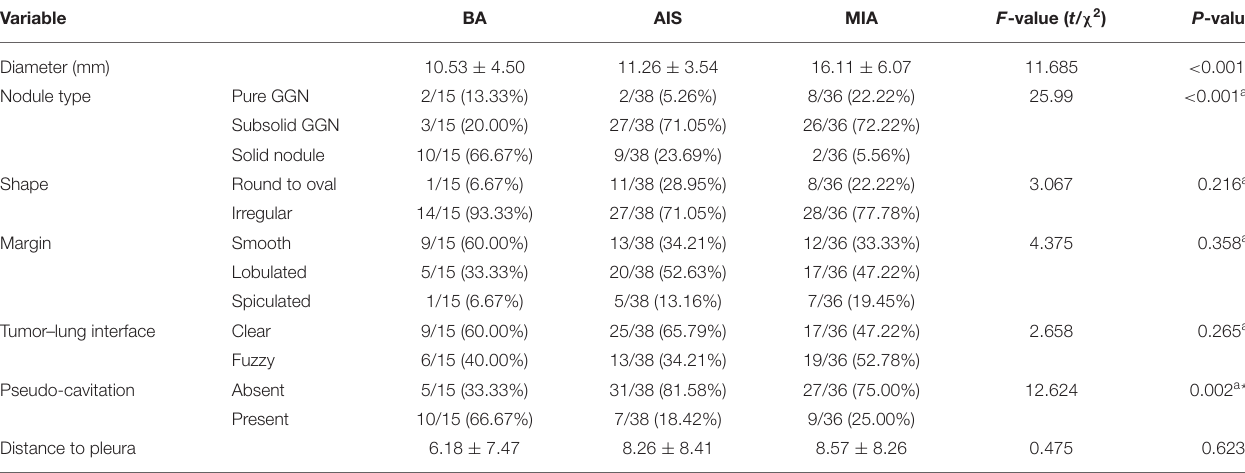
TABLE 2 | Differences in CT findings among BA, AIS, and MIA.